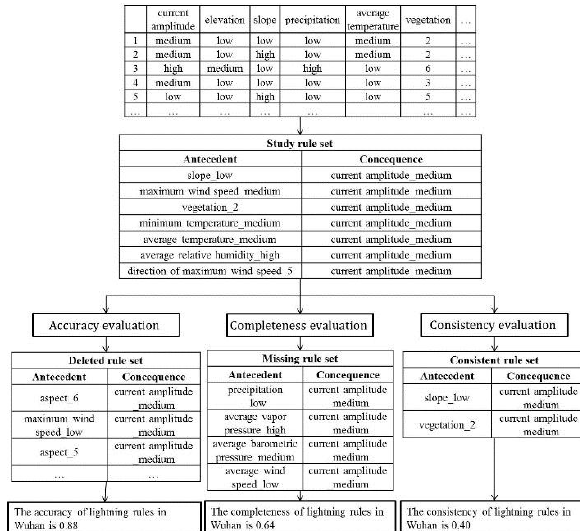
Figure 4. Reliability evaluation of the lightning association rule in Wuhan